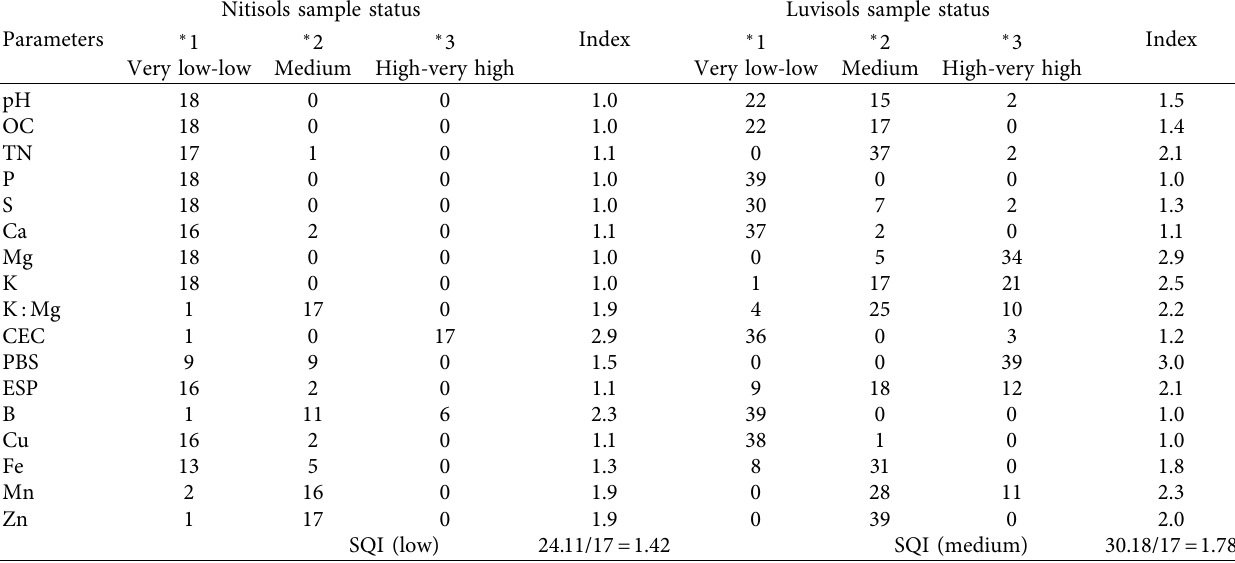
Table 5: Te soil quality of lands in the Nitisols and Luvisols based on the soil fertility/nutrient/index approach.